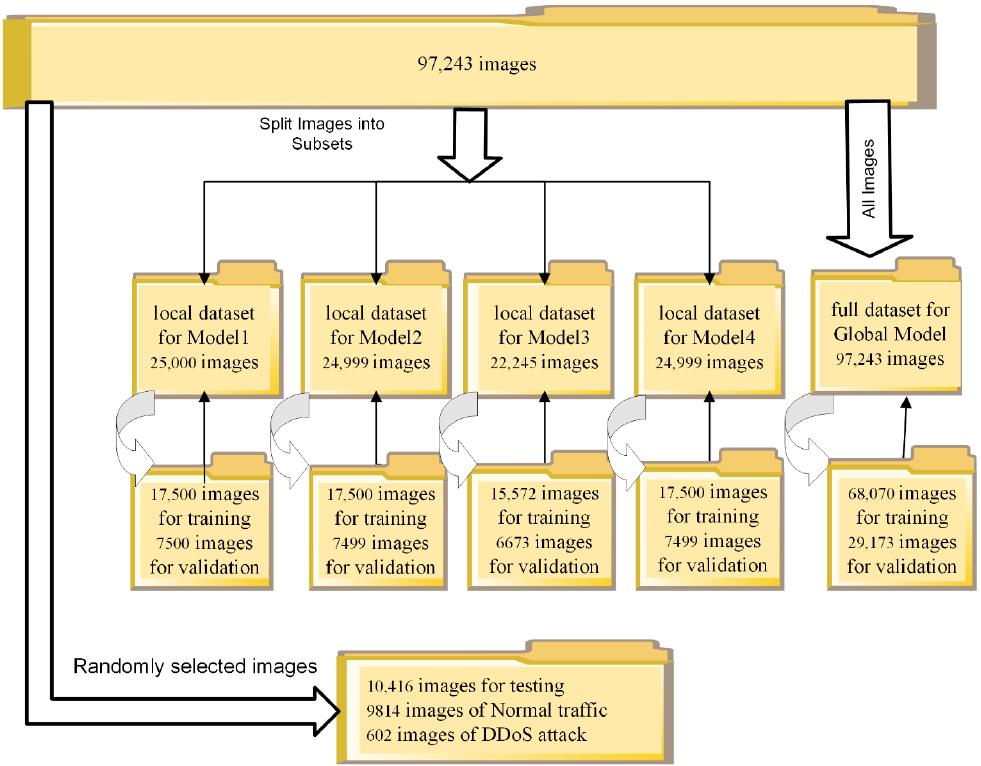
Figure 5. Partitioning of images for traditional transfer learning using the ResNet50 architecture.